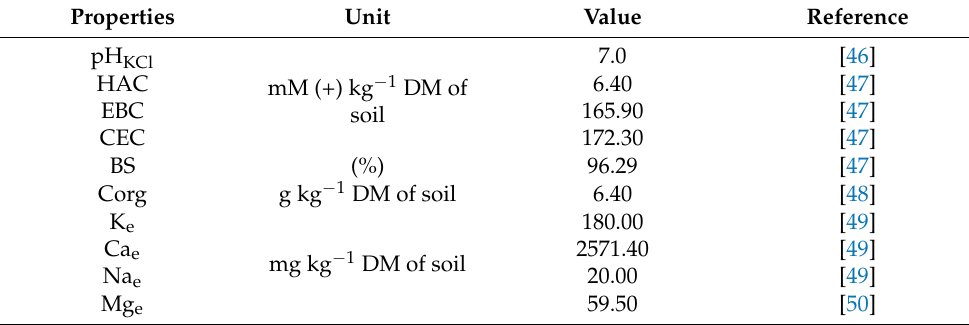
Table 1. Some physico-chemical properties of the soil used in the experiment.